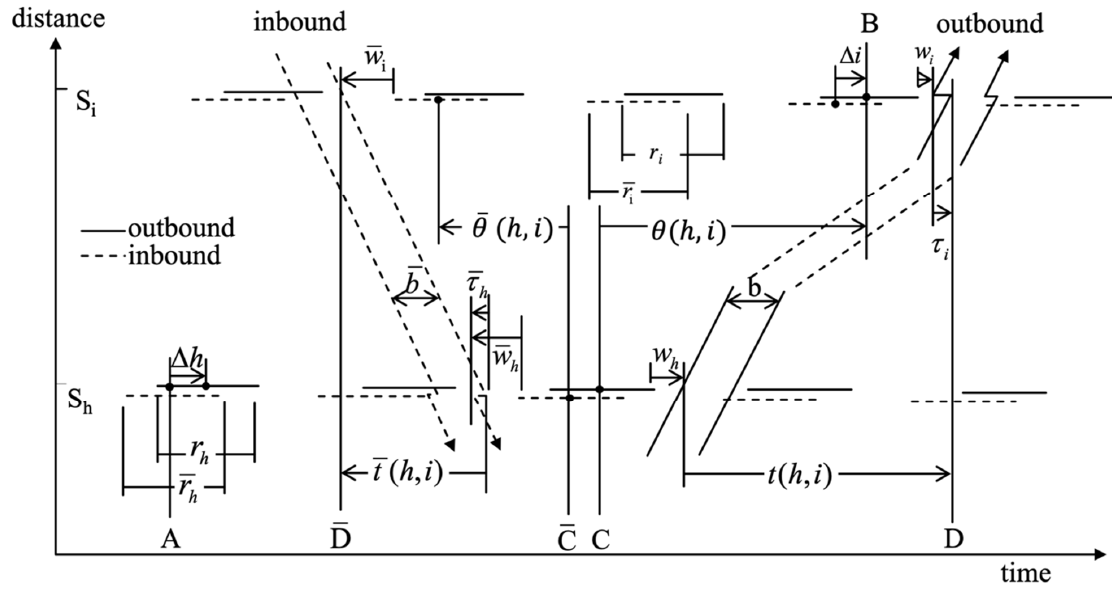
Figure 2. Bidirectional coordination optimization model based on MAXBAND (Morgan and Little, 1964).